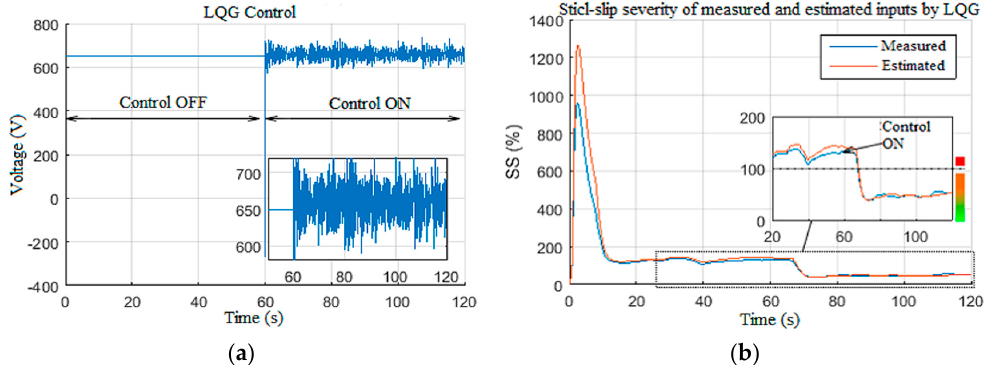
Figure 26. LQG response under structured disturbances: ( a ) LQG control voltage; ( b ) stick-slip severity.